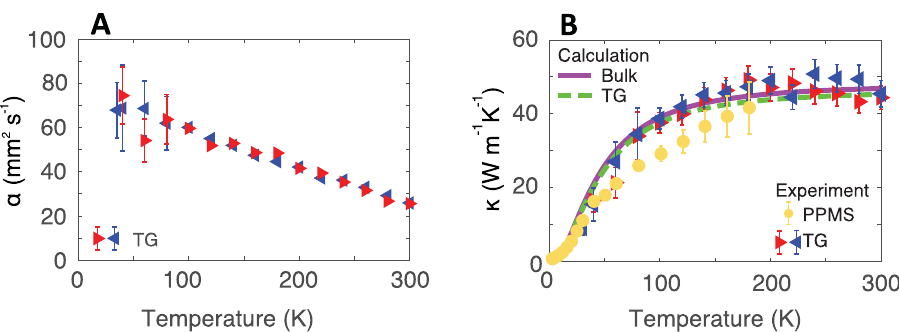
Fig. 2 Temperature dependence of thermal diffusivity and thermal conductivity. A Thermal diffusivity along the chain axis versus temperature for grating period L = 9.8 μ m (heating: red right-point triangles; cooling: blue left-point triangles). An increase in the thermal diffusivity is observed as temperature decreases. B Thermal conductivity along the chain axis versus temperature measured by TG for L = 9.8 μ m (heating: red right-point triangles; cooling: blue left-point triangles) and PPMS (yellow circles). The thermal conductivity is approximately constant from ∼ 300 − 220K, below which the thermal conductivity decreases. The trend and corresponding values from PPMS and TG with L = 9.8 μ m are in reasonable agreement, suggesting that phonon mean free paths are less than ~ L /2 π ~1.5 μ m. Calculated thermal conductivity versus temperature obtained using Eq. (1) (solid purple line: bulk; dashed green line: L = 9.8 μ m).